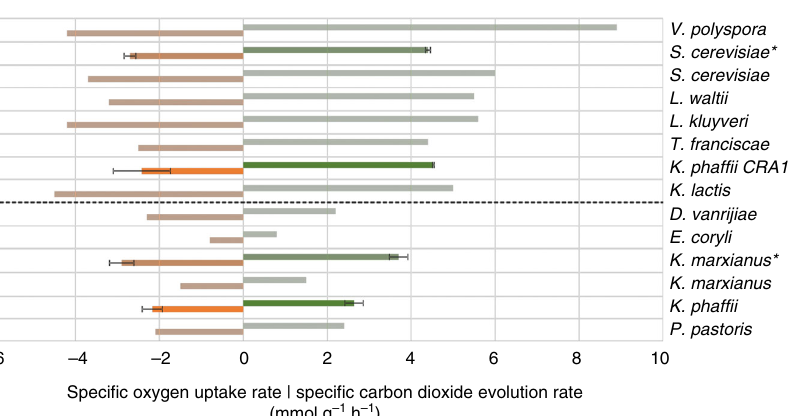
Fig. 2 The CRA1 overexpression strain exhibits a short-term Crabtree phenotype. K. phaf fi i strains were grown in chemostat at D = 0.1 h − 1 in steady state, followed by a glucose pulse of 9-11 g L − 1 . Data of K. phaf fi i control, overexpression strain, Saccharomyces cerevisiae CEN.PK113-5D and Kluyveromyces marxianus CBS712 (indicated with an asterisk) are shaded dark. The data of other yeast species were retrieved from Hagman et al. 25 and shaded light. They comprise the Crabtree positive species (above the dashed line) Vanderwaltozyma polyspora, S. cerevisiae, Lachancea waltii, Lachancea kluyveri , Torulaspora franciscae, Kluyveromyces lactis, and the Crabtree negative species (below the dashed line) Debaryomyces vanrijiae, Eremothecium coryli , K. marxianus and P. pastoris (syn. Komagataella sp.) . a Comparison of speci fi c glucose consumption (blue) and ethanol formation (red) rates. The speci fi c glucose uptake rate of the CRA1 overexpression strain was higher compared to the control strain and other Crabtree-negative yeasts. Ethanol production by the CRA1 overexpression strain was comparable to other short-term Crabtree-positive yeasts, while the control strain did not produce ethanol, same as the other Crabtree-negative yeasts. b O 2 uptake (orange) and CO 2 evolution rates (green) among other yeasts based on their short-term Crabtree effect. Calculated CO 2 evolution rate values for the CRA1 overexpression strain were in the range of other short-term Crabtree-positive yeasts (see ref. 25 ). Mean values of the duplicate bioreactor cultivations for the control and overexpression K. phaf fi i strains are presented. Error bars represent the standard deviation